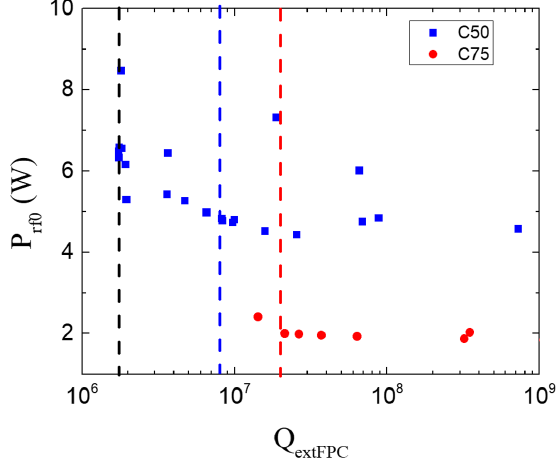
FIG. 19. Computed rf heat load P rf 0 ( ϕ ¼ 0 ° in eigenmode ¼ 7 MV = m as a computations) assuming T ¼ 2 . 07 K and E acc function of Q for C50 and C75 cavities in the CM extFPC configuration. The vertical dashed lines correspond to the design value of Q for a C50 cavity ( 1 . 74 × 10 6 with flush tuner extFPC plungers), its specified value of 8 . 0 × 10 6 (after bench tuning), and the Q of 2 . 0 × 10 7 for a C75 cavity, which is both its extFPC specified and design